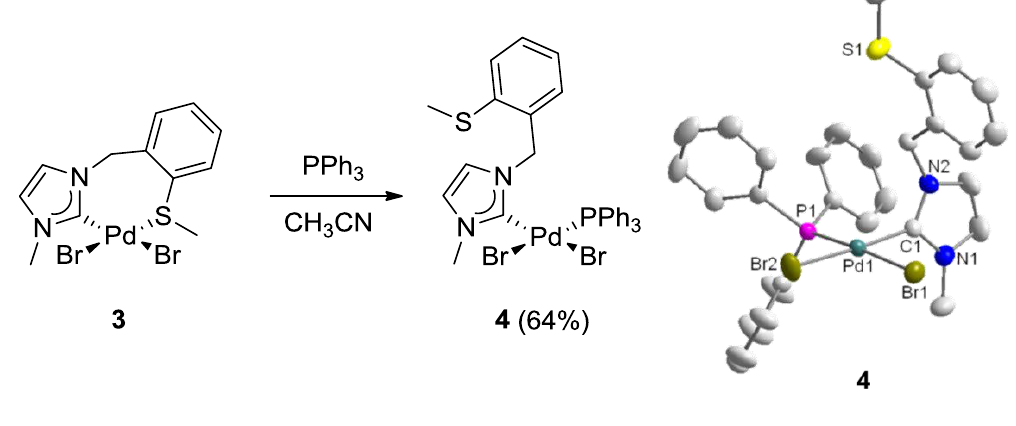
Figure 6. 1 H-NMR spectrum of 4 (300 MHz, CDCl